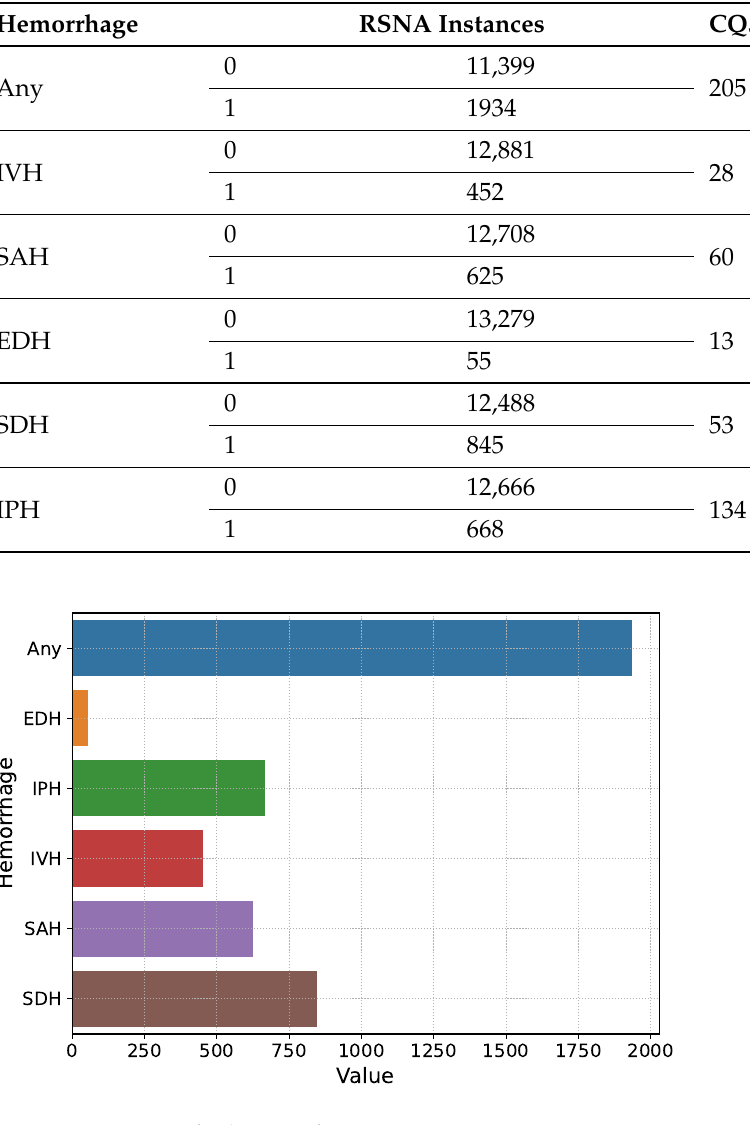
Figure 2. Overview of subtypes of ICH.